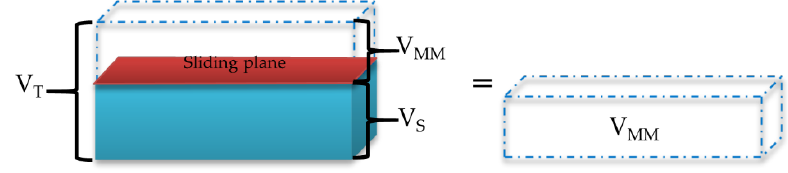
Figure 6. Graphical illustration of volumetric mass movement calculations.